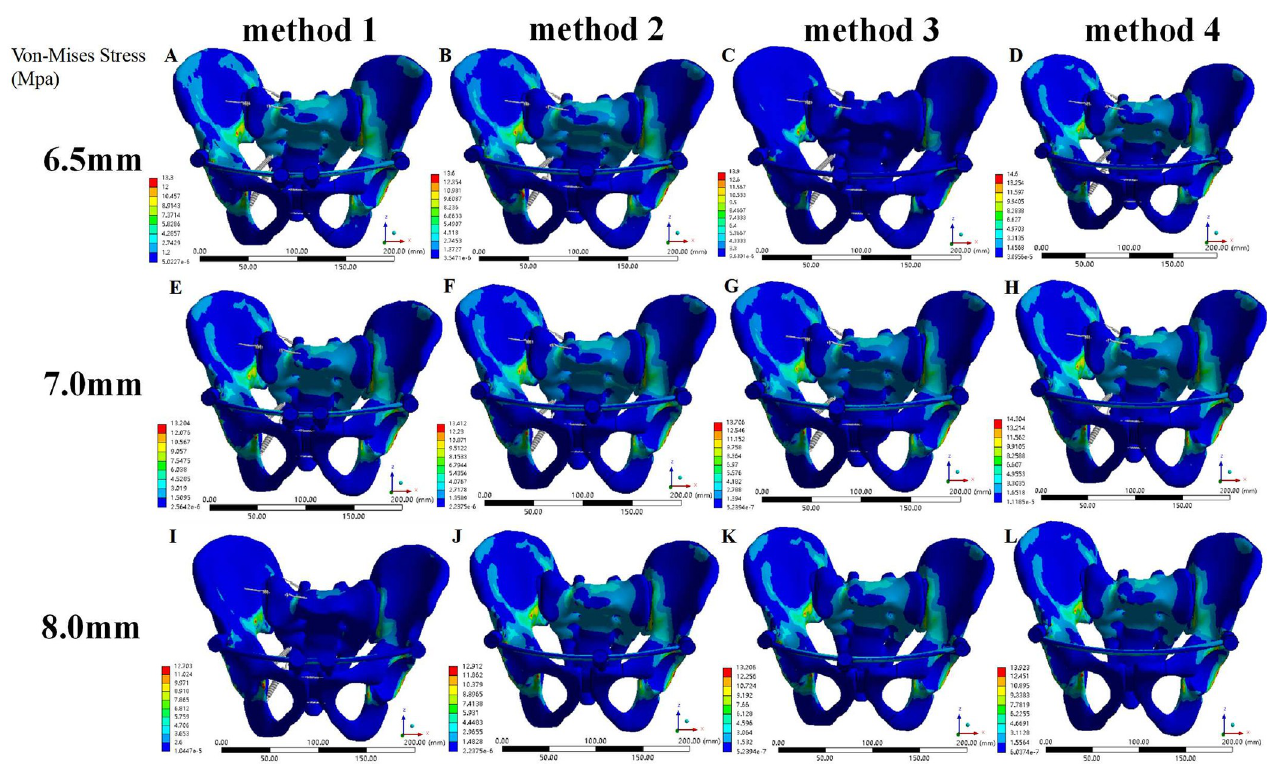
Fig 9. Von Mises stress distribution of pelvic models fixed with pedicle screws under a vertical load. (A) Model 4. (B) Model 5. (C) Model 6. (D) Model 7. (E) Model 8. (F) Model 9. (G) Model 10. (H) Model 11. (I) Model 12. (J) Model 13. (K) Model 14. (L) Model 15.